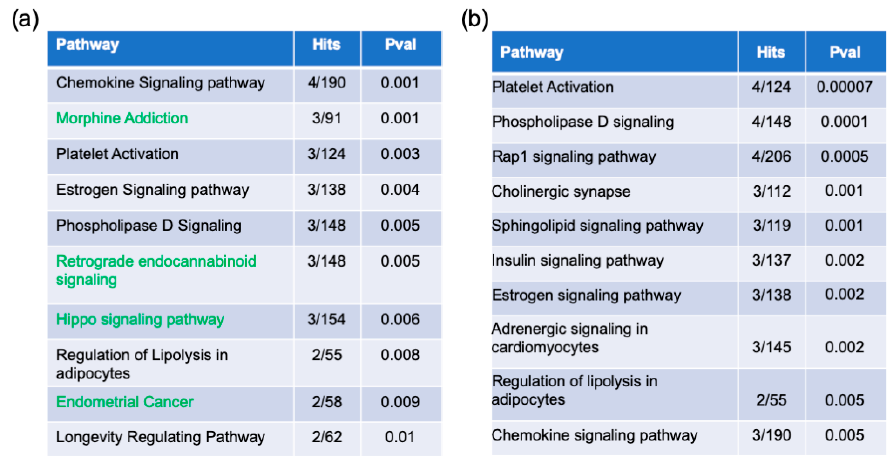
Figure 4. Top 10 pathways. ( a ) Top 10 pathways identified from the AD/healthy switch genes. ( b ) Top 10 pathways identified from AD/AsymAD switch genes. The pathways shared between both analyses are indicated in black. The pathways shown in green are unique for each analysis. Pval: p -value.